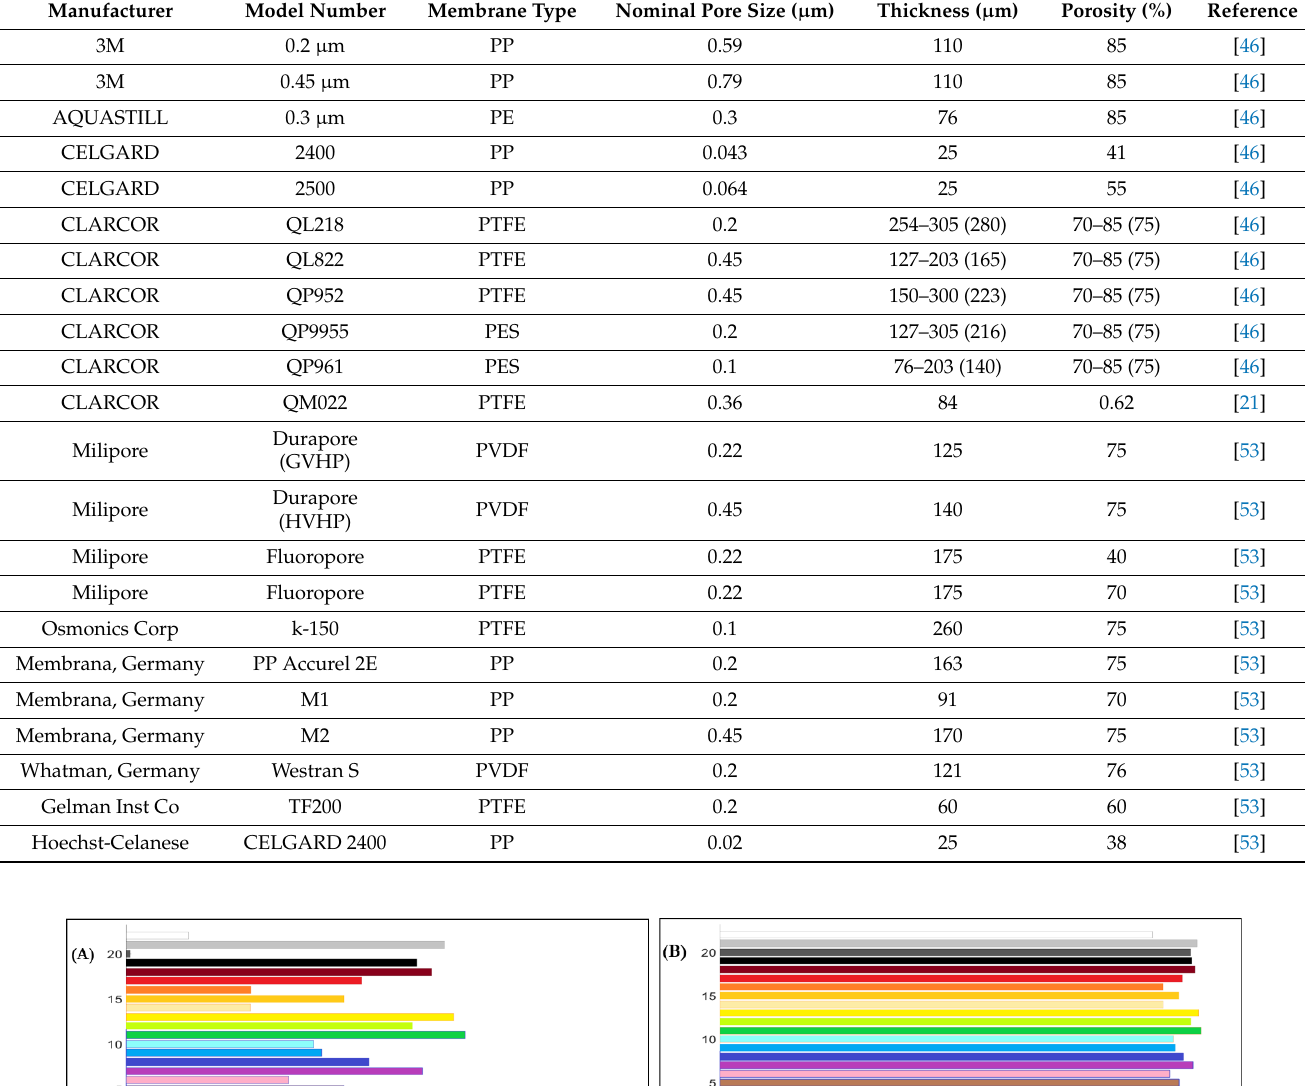
Table 2. Membranes selected for this study, and characteristics provided by their manufacturers.